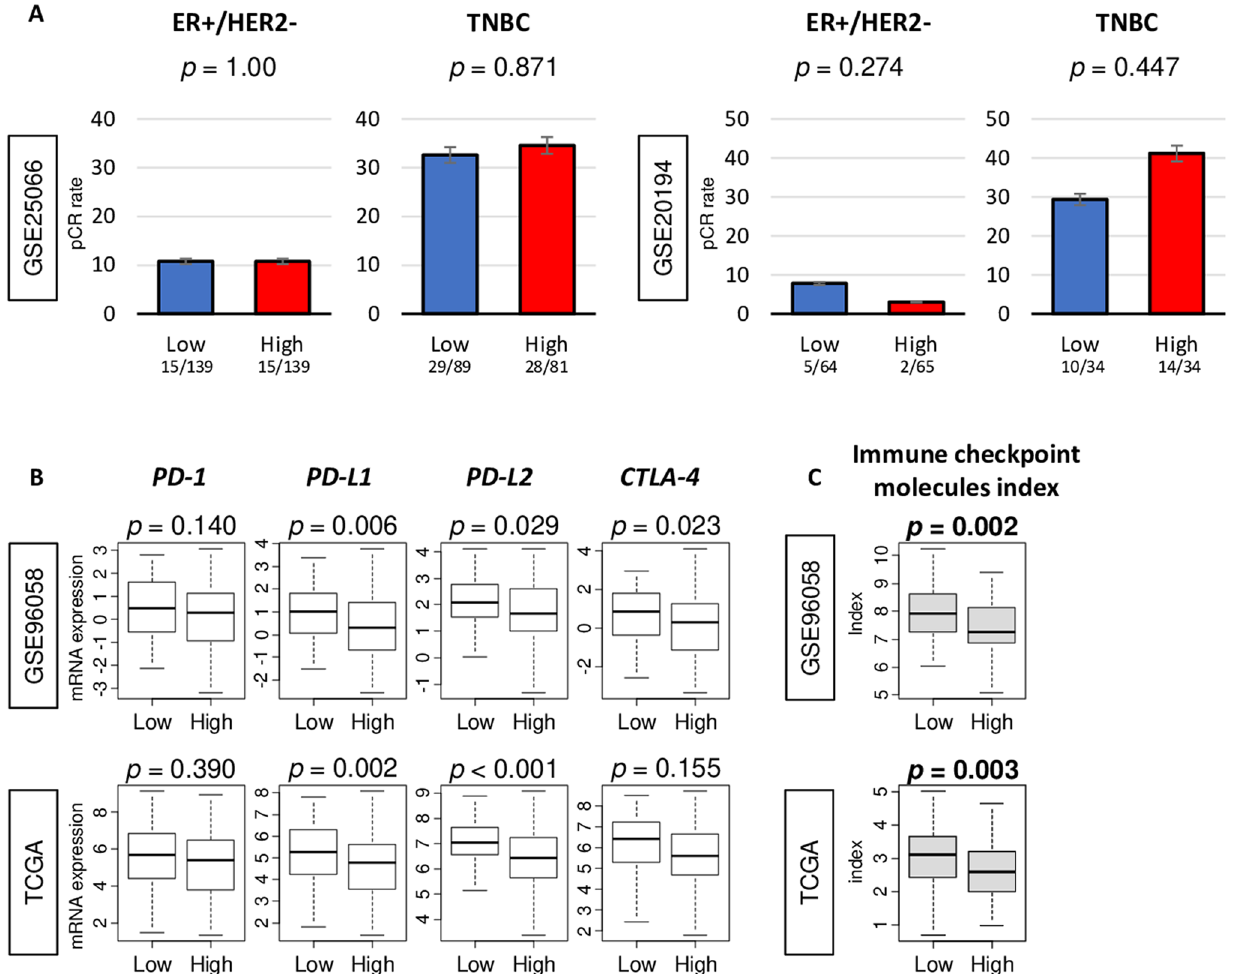
Figure 6. Association of adipogenesis score with neoadjuvant chemotherapy (NAC) response and expression of immune checkpoint molecules in TNBC. (A) Bar plots of pathological compete response (pCR) rate after NAC between low (blue) and high (red) adipogenesis score in ER+/HER2− and TNBC in the GSE25066 and GSE20194 cohorts. The numbers under the chart are pCR case number/number of patients in that group that makes the pCR rate. Error bar showed Standard Error. P -value was calculated by Fisher’s test. (B) Boxplots of comparison between low- and high-adipogenesis score with mRNA expression of PD-1/ PDCD1 , PD-L1/ CD274 , PD-L2/ PDCD1LG2 , and CTLA4 genes, and (C) immune checkpoint molecules index in TNBC in the GSE96058 and TCGA cohorts. P -value was calculated using Mann–Whitney U test. Median value was used as the cut-off to divide into low- and high- adipogenesis score groups within each cohort. PD-1 programmed cell death 1; PD- L1 programmed cell death 1 ligand 1, PD-L2 programmed cell death 1 ligand 2, CTLA4 cytotoxic T-lymphocyte- associated protein